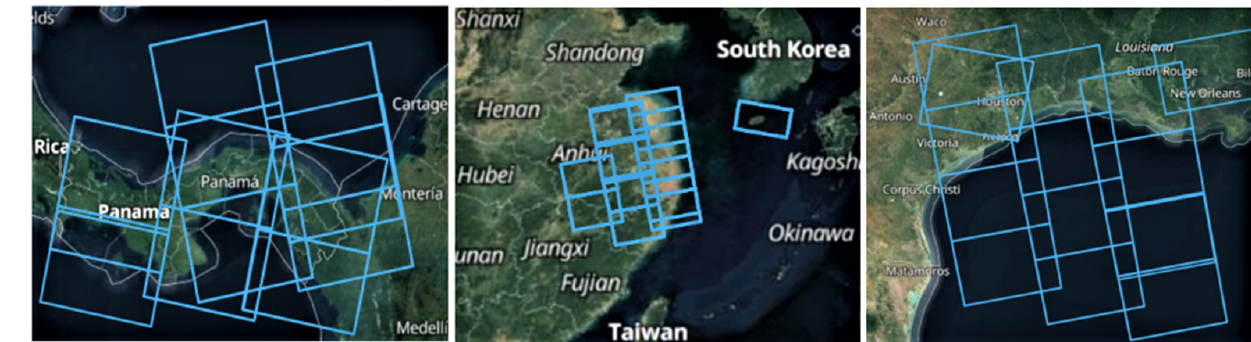
Figure 1. Representative regions acquired from the Sentinel-1 IW. Blue boxes indicate the coverage of each image. Table 1. Detailed information for the original Sentinel-1 imagery.